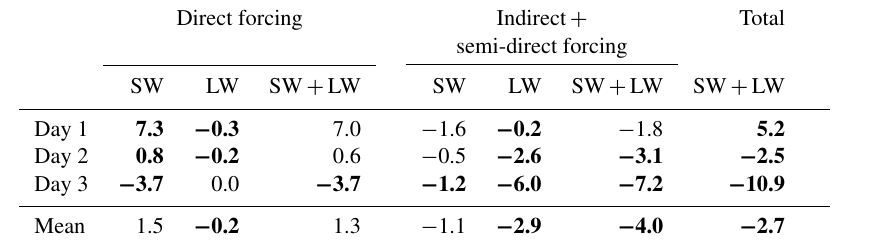
Table 2. Diurnal-average direct forcing, indirect plus semi-direct forcing, and sum of forcings (in Wm − 2 ) from the overlying absorbing aerosol for the lightly drizzling case ( N a , sulfate = 150mg − 1 ) on day 1 (0–24h), day 2 (24–48h), and day 3 (48–72h). The 3-day average radiative forcing is indicated in the last row. Boldface indicates results exceeding the uncertainty range derived from the baseline ensemble spread.